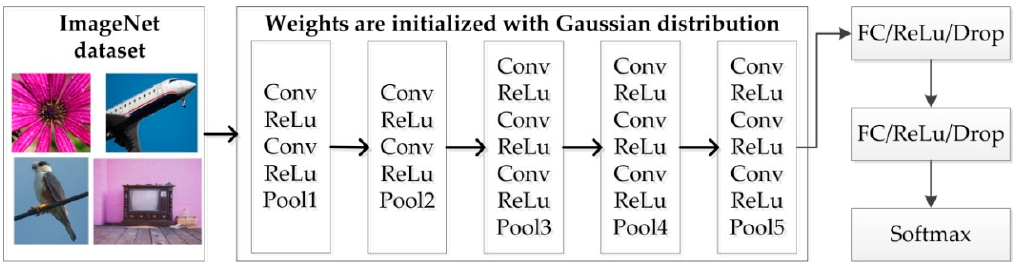
Figure 4. Workflow of training on the ImageNet dataset for VGG16.